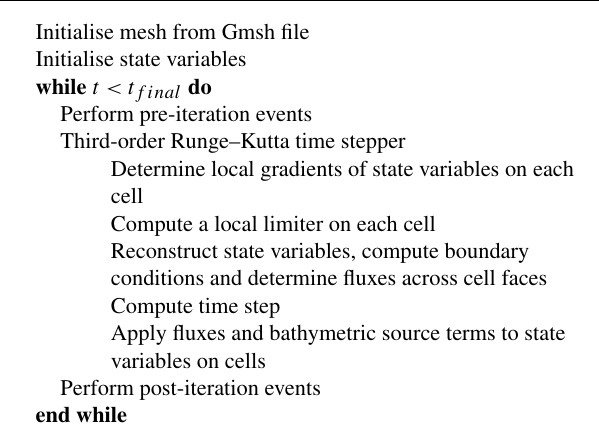
Figure 4. (a) The incoming water level incident on the x = 0m boundary and comparison between VOLNA and laboratory results at different locations for benchmark problem 2: (b) x = 4 . 521, y = 1 . 196; (c) x = 4 . 521, y = 1 . 696; (d) x = 4 . 521, y = 2 . 196. Algorithm 1 Code structure of